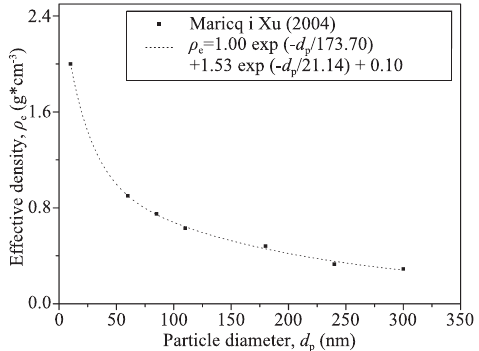
Fig. 1 Effective density of diesel exhaust particles obtained from a diesel engine operated at idle-speed conditions. The dashed lines display the best fits to the experimen - tal data.